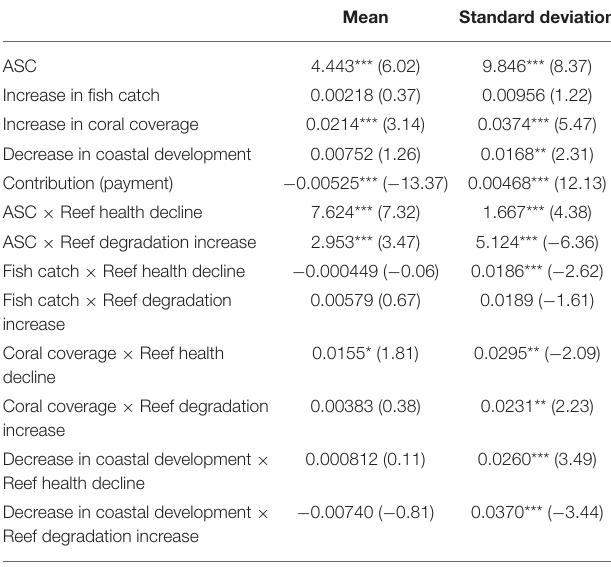
TABLE 4 | Estimation results of the MMNL model with interaction